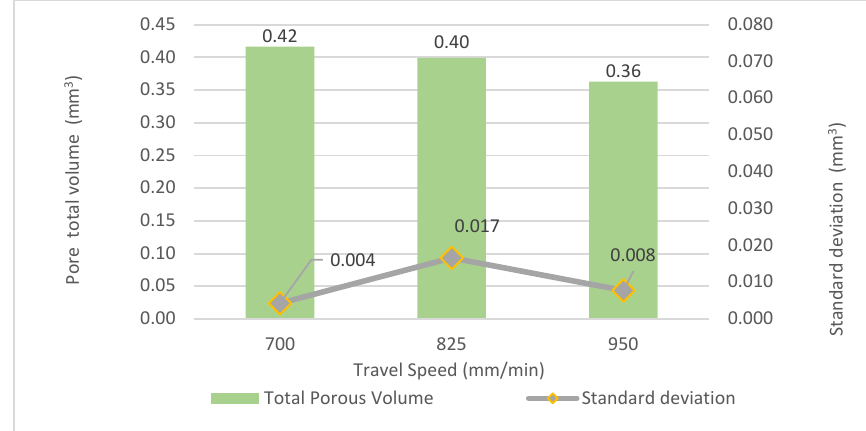
Figure 7. Pore total volume versus travel speed.